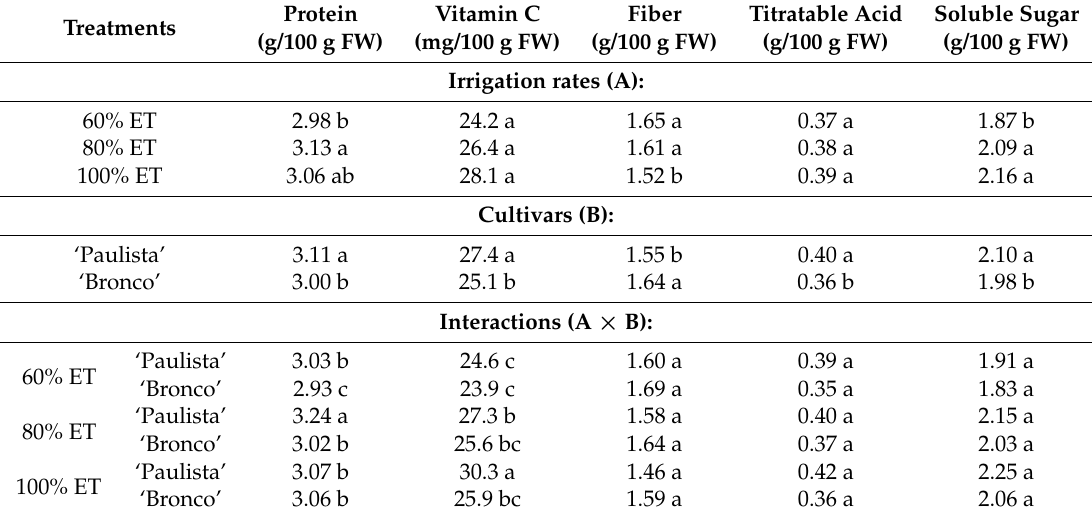
Table 6. Effect of different irrigation water volumes based on supplying 60, 80 or 100% of evapotranspiration (ET) on the content of protein, vitamin C, fiber, titratable acid, and soluble sugar for two green bean